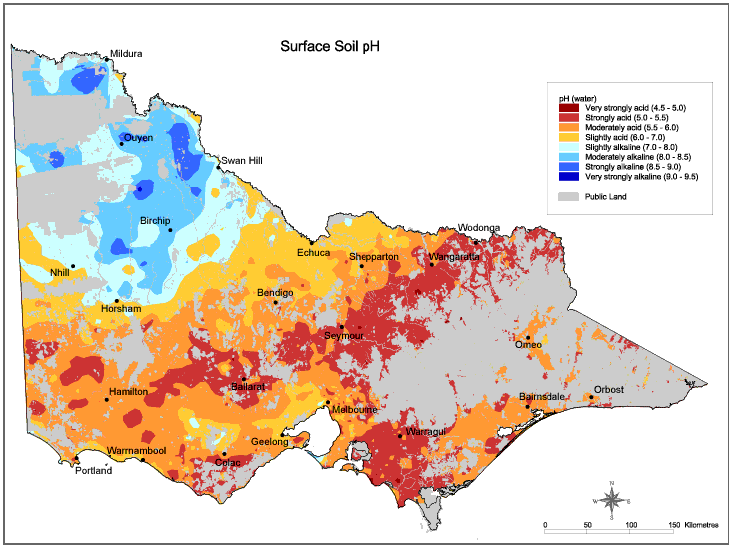
Figure 6. Statewide overview map of surface soil pH.  State of Victoria, Department of Primary Industries 1997 Reproduced with